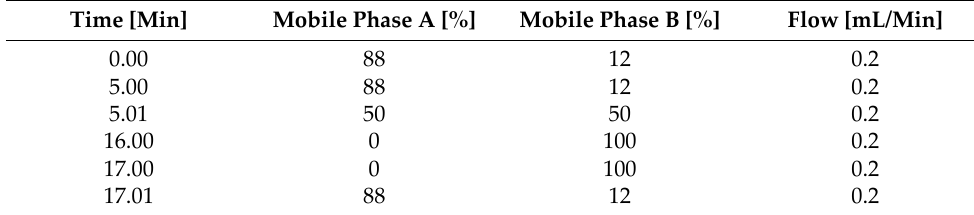
Table 1. LC‑MS/MS